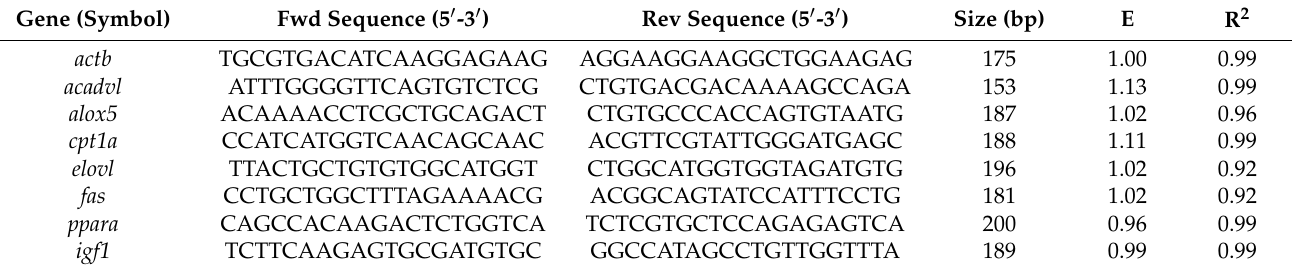
Table 3. Primers pairs used for q-PCR Primer sequences, amplicon sizes in base pairs (bp), reaction efficiencies (E), and Pearson (cid:48) s coefficients of determination (R 2 ) are